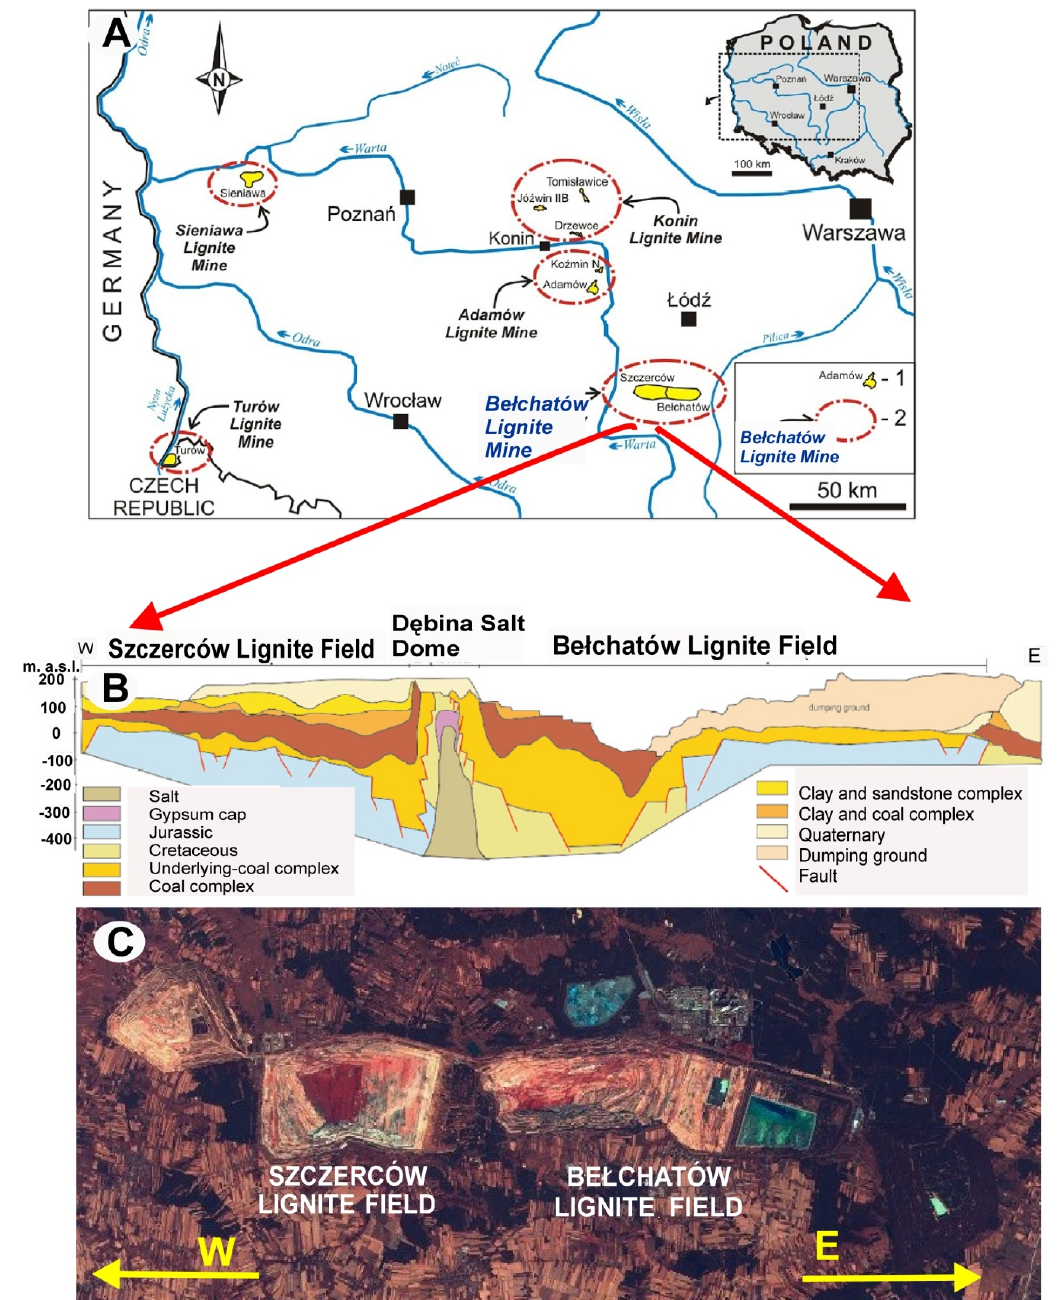
Figure 1. The Be ł chatów and Szczerców deposits: ( A ) Map of Poland showing locations of some Figure 1. The Bełchat ó w and Szczerc ó w deposits: ( A ) Map of Poland showing locations of some mined mined deposits [13]; ( B ) Cross-section through the Be ł chatów lignite deposit [18]; ( C ) Location of the deposits [13]; ( B ) Cross-section through the Bełchat ó w lignite deposit [18]; ( C ) Location of the study study area depicted on the color composition of a Sentinel satellite image. area depicted on the color composition of a Sentinel satellite The deposits studied in the present work are located in the main fault zone bounding the deposit from the south. At the sampling site, contact between the Neogene and Mesozoic sediments is disturbed, and tectonic in nature, running along a NE–SW fault. The Mesozoic relief of the Be ł chatów region, formed as a result of Laramide-age movements, underwent very strong peneplenization in the Paleogene [20]. As a result, the Cretaceous deposits in the west and southwest of the region under study were destroyed completely. The period of peneplenization probably lasted throughout the Paleogene, as no sediments of this age are found in the Be ł chatów region. Only the more erosion-